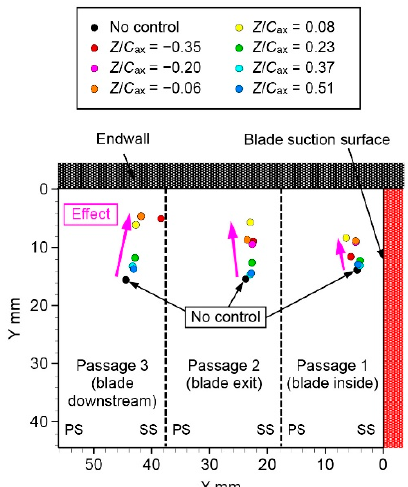
Figure 10. Center positions of passage vortex at various plasma actuator locations (Re out = 1.8 × 10 4 ).